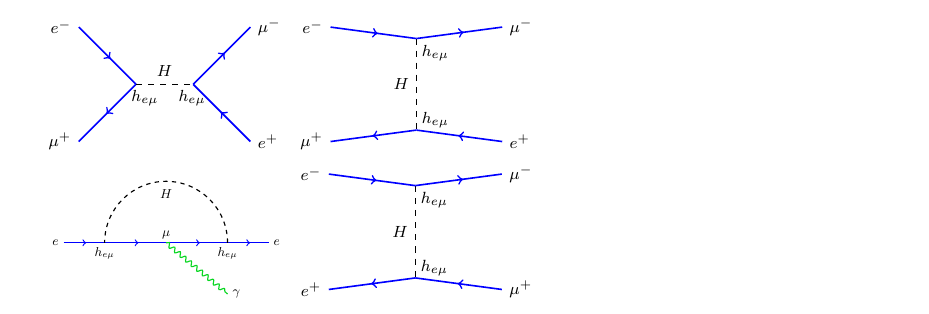
FIG. S2. Feynman diagrams for the magnetic dipole moment Figure 2. Feynman diagrams for the H contribution to muonium-antimuonium oscillation ( upper of electron induced by H with the coupling h eµ . left and right ), electron g − 2 ( lower left ), and the LEP e + e − → µ + µ − process ( lower right ) with the Phys. Rev. D 88 , no. 9, 093010 (2013) [arXiv:1309.0774 LFV coupling h e µ . Figure from Ref. [20]. [hep-ph]].